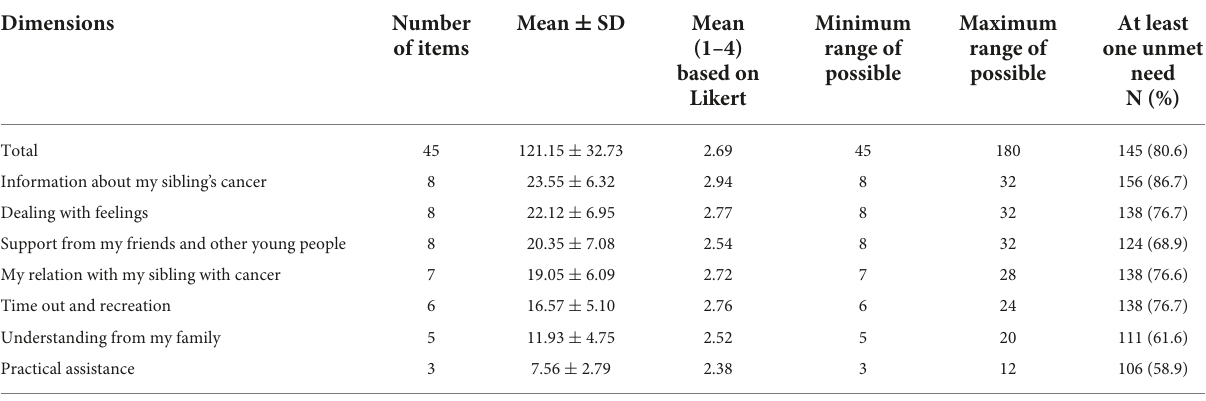
variables and the mean summary score of PSNs. Variables with significant correlation with PSNs in correlation analysis were entered into the regression model ( Tables 3 , 4 ). Based on the regression coefficients, a significant relationship was observed between the mean summary score of PSNs with the duration of cancer ( β = –2.199, p = 0.006) and mother’s age ( β = –2.580, p = 0.029). This standardized beta coefficient ( β ) means that for one unit change in the duration of cancer and mother’s age, the mean score of PSNs decreases by –2.199 and –2.805 units, respectively, in other words, the mother’s age has a higher